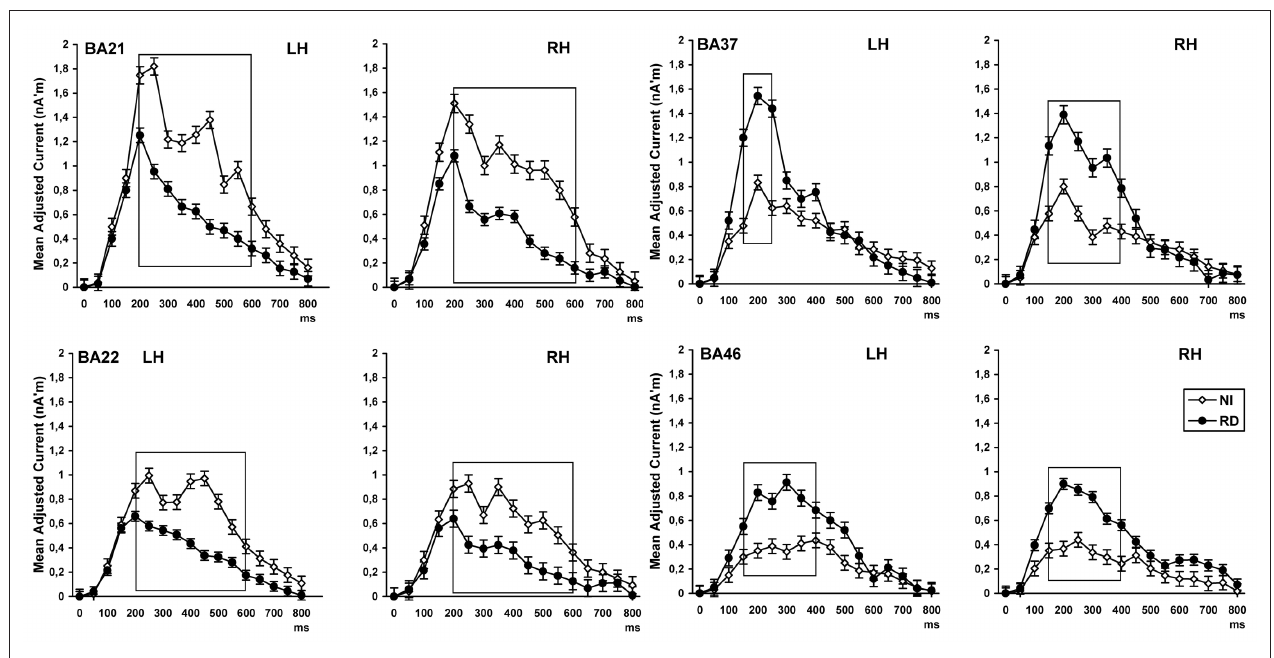
ROI and estimated current in each subsequent time bin. Time windows of significant group differences are marked by boxes. BA22, superior temporal gyrus; BA21, middle temporal gyrus; BA46, rostral middle frontal cortex; BA37, fusiform gyrus.